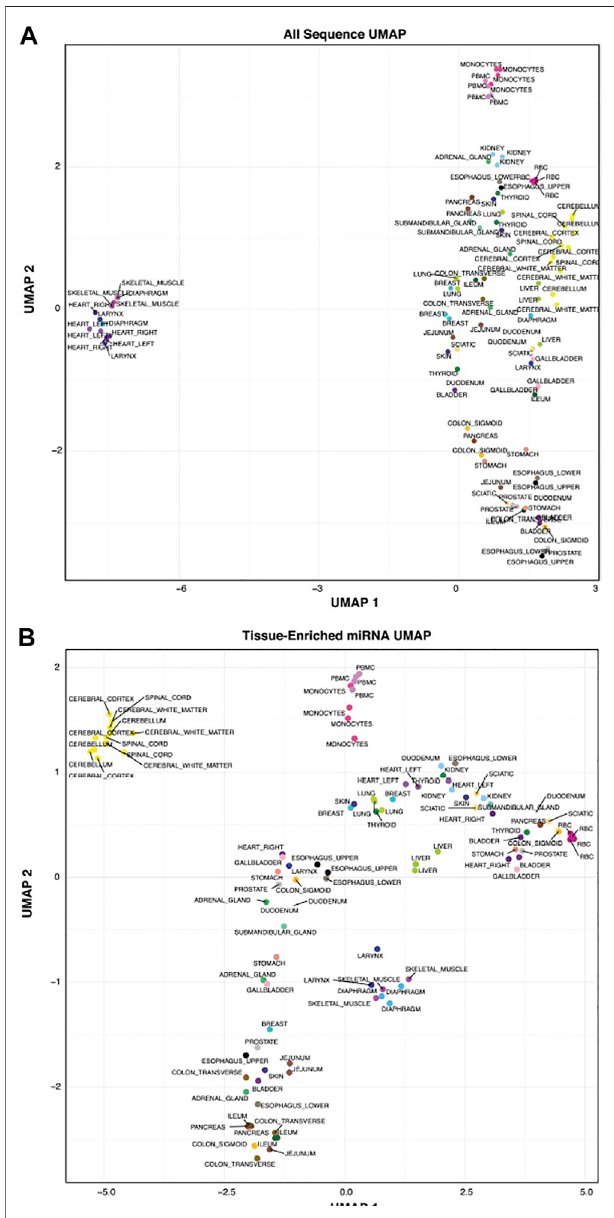
FIGURE 6 | Tissue Clustering. We clustered the tissues using all sequencesinPanel (A) .Usingtissue-elevatedmiRNA sequences inPanel (B) , the tissue samples clustered into tighter groups. In both fi gures, the tissue replicates show low variability.